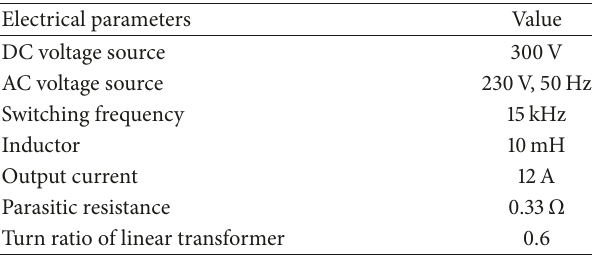
Table 1: Assumption to model grid connected